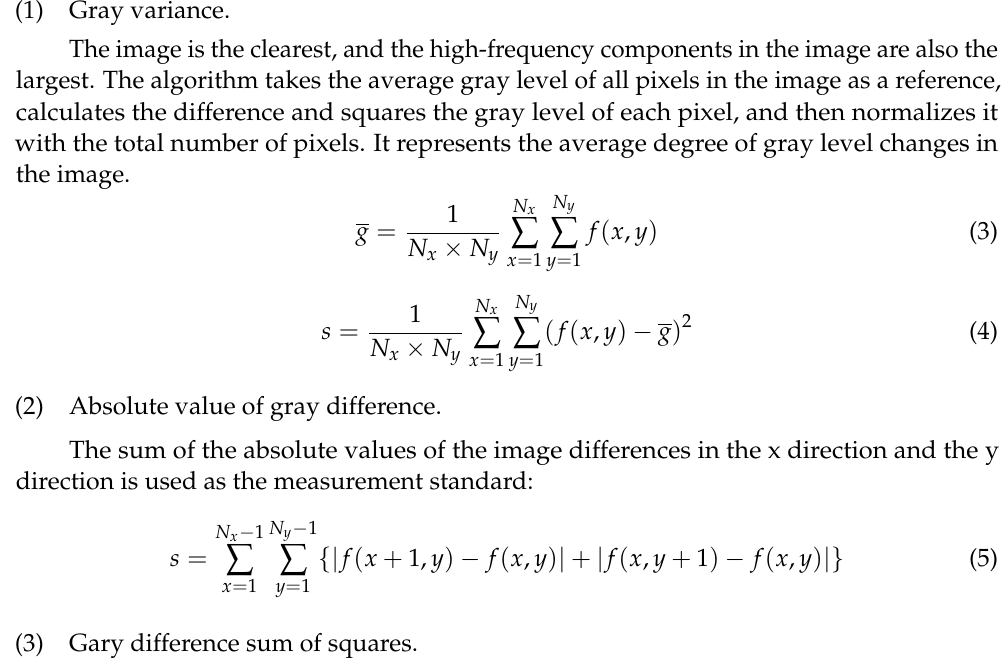
algorithm based on the combination of a-contrario and FSG frequency domain